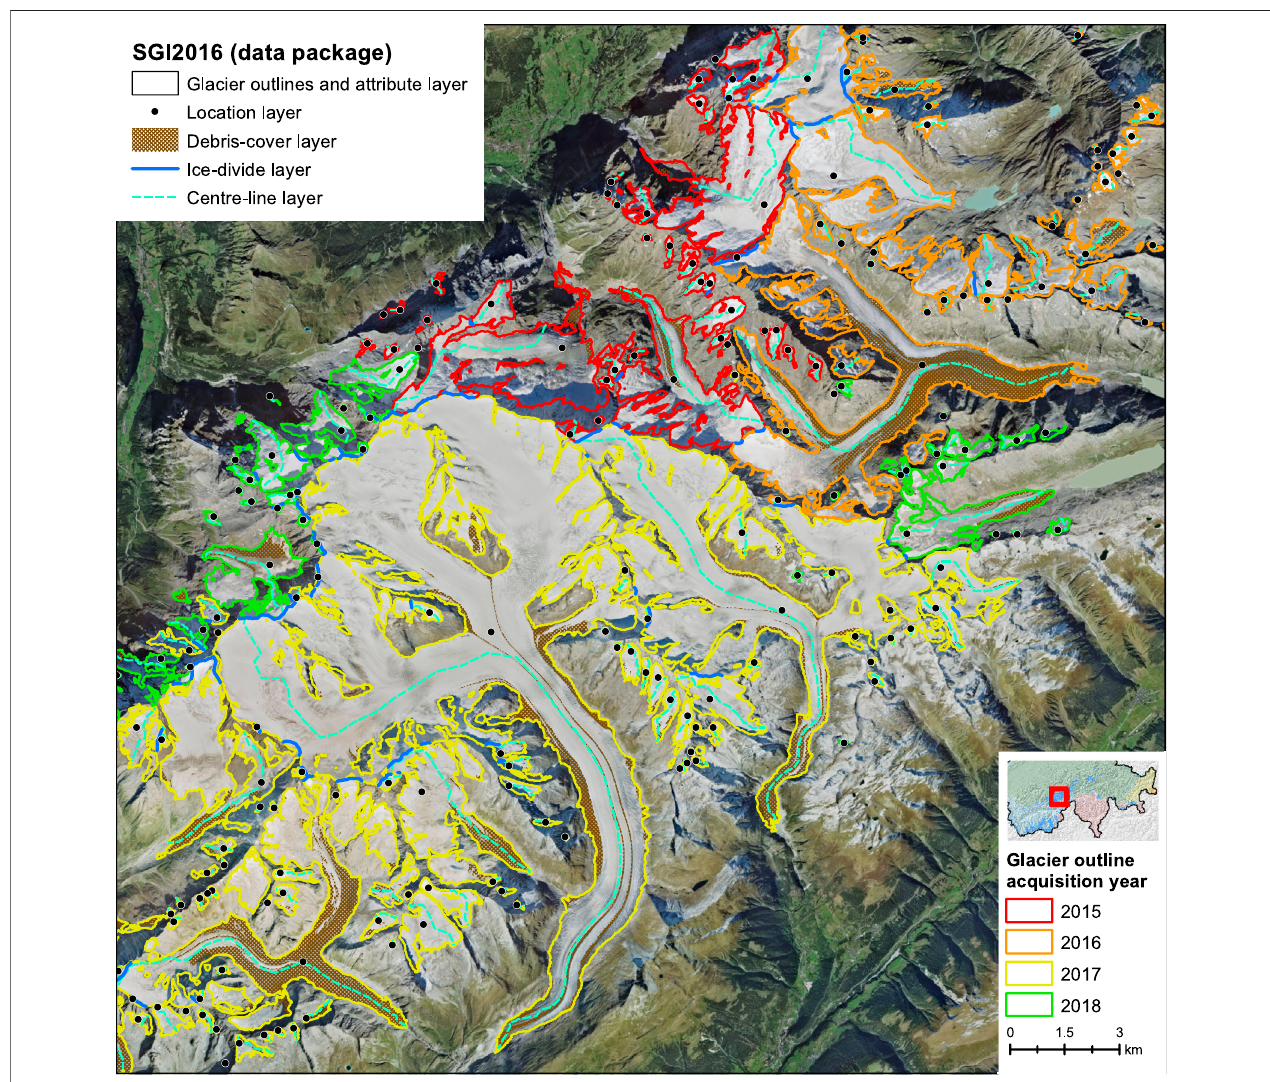
FIGURE5| Overviewonthe fi lesprovidedwiththeSGI2016datapackageintheareaofGrosserAletschgletscher.Theglacieroutlinesarecoloredaccordingtothe acquisition year of the aerial image used for digitizing. Background: SWISSIMAGE orthoimagery composite.